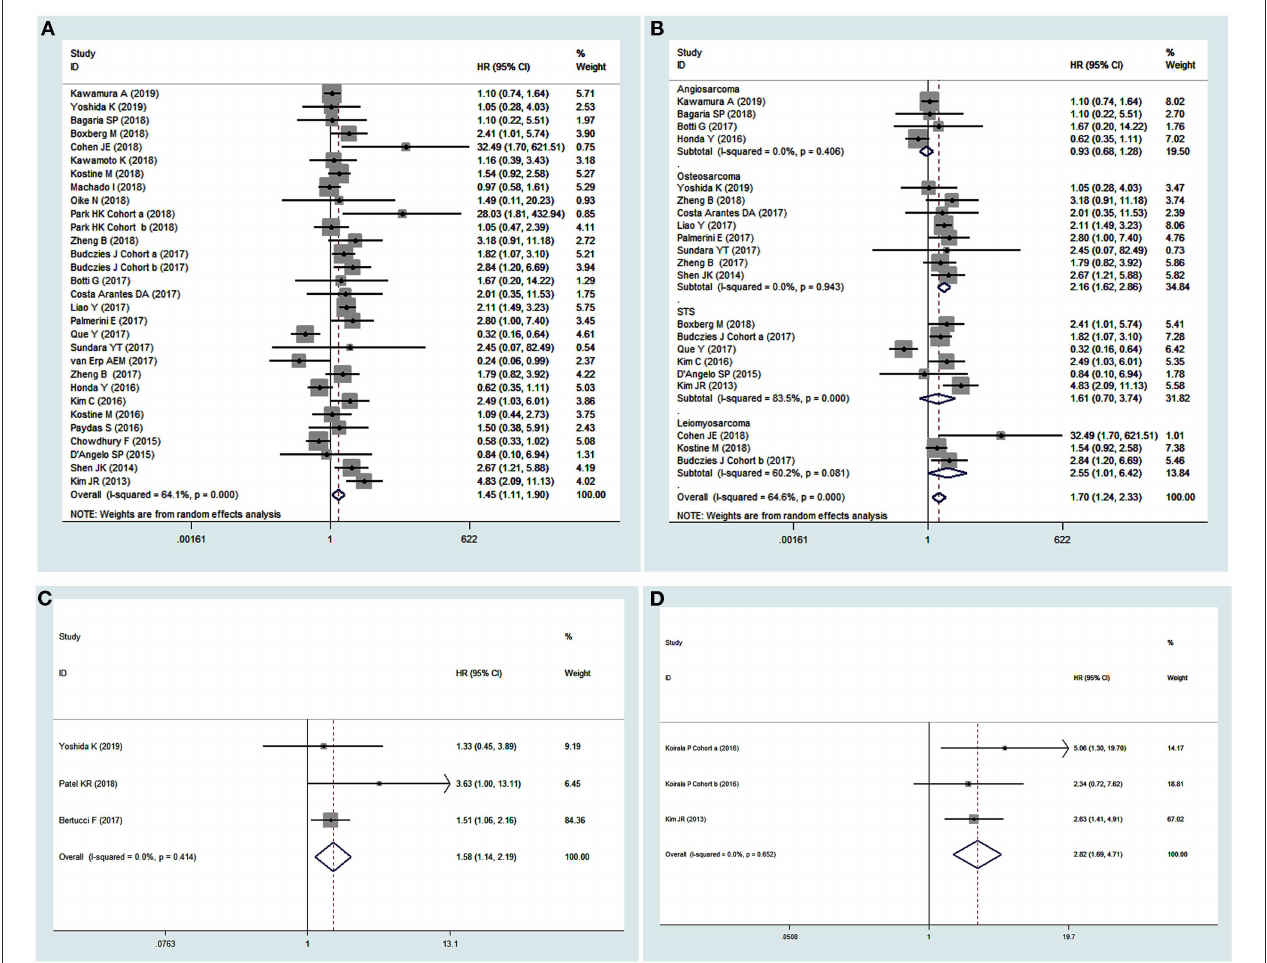
FIGURE 2 | Forest plots of pooled HR for pooled overall survival (OS) (A) and OS stratified by tumor subtypes (B) , metastasis-free survival (C) , and event-free survival (D)